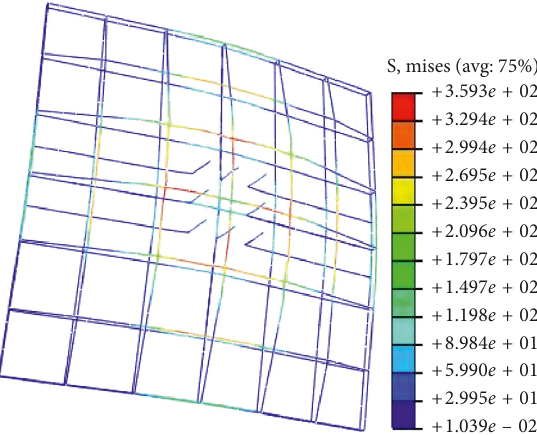
Figure 13: Typical stress nephogram of steel